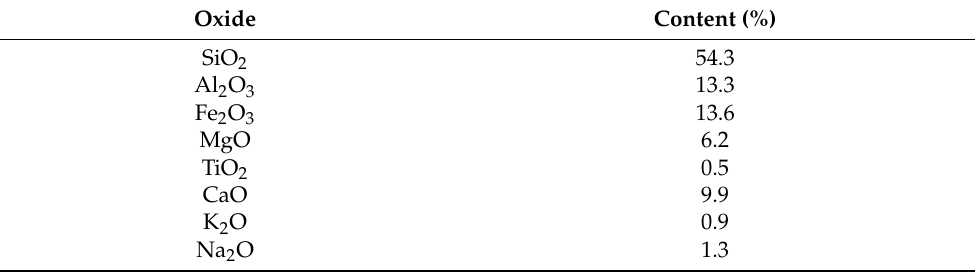
Table 1. Chemical composition of basalt.